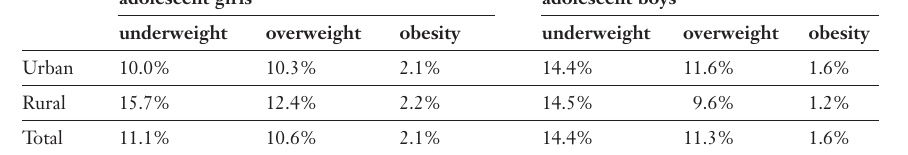
Table 4 Overweight and obesity prevalence among Turkish ado- lescents with respect to living